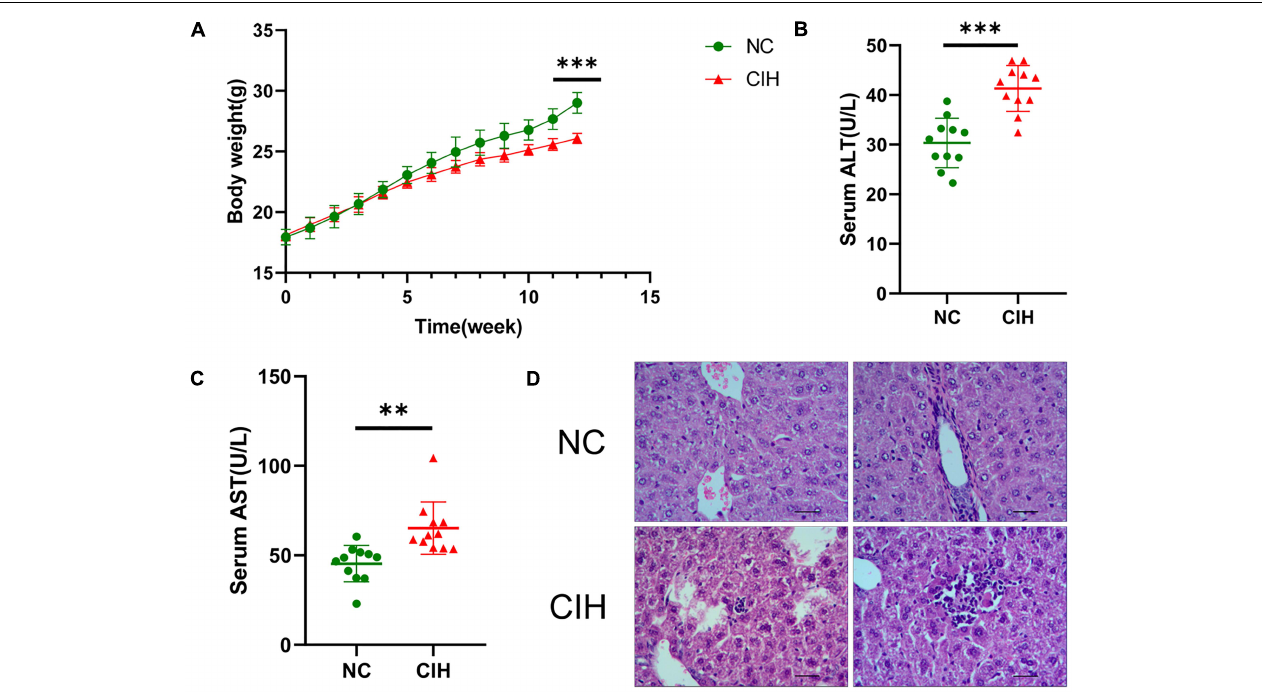
FIGURE 1 | Effect of CIH on body weight, liver enzymes, and liver histology. (A) The body weight of mice in CIH group is significantly lower than that in NC group after 12 weeks of exposure. (B) Both serum ALT and (C) AST levels of mice in CIH group are significantly higher than those in NC group ( n = 11 each group). (D) Hepatic morphology was found to be normal in the NC group with no obvious lobular necrosis or portal inflammation (original magnification, isd t; scale bar, 50 ic). The liver tissue of CIH group revealed lobular necrosis and portal inflammation (original magnification, group scale bar, 50 µ s). ∗∗ p < 0.01; ∗∗∗ p <